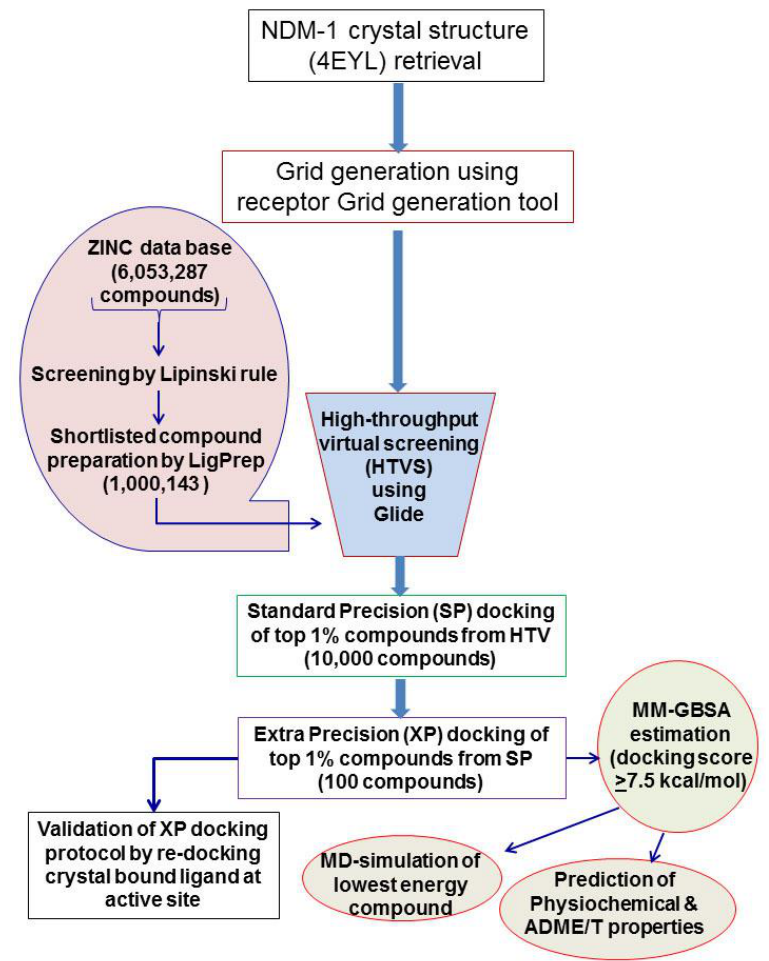
Figure 7. The flowchart of the various steps undertaken in the study to identify the novel